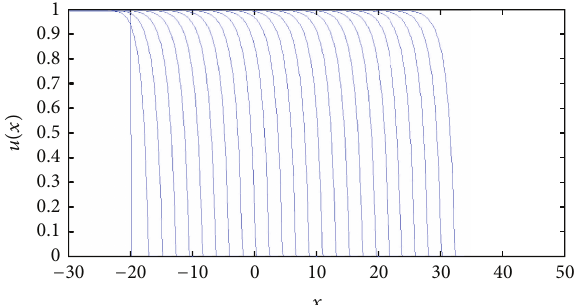
Figure 14: Evolution of a compact support function as initial con- dition under the reaction-diffusion convection process described by (39). The numerics show that as the time grows, the approximative solution tends to the sharp traveling wave solution. Profiles are plotted for ℎ 󸀠 (𝑢) = 𝛼 + 𝛾𝑢 at equal time intervals 𝑡 = 1,2,3, .. . with 𝑔(𝑢) = 𝑢(1 − 𝑢) and 𝐷(𝑢) = 𝑢(1.0 + 𝛽𝑢) for 𝛽 = 𝑘 = 1 .